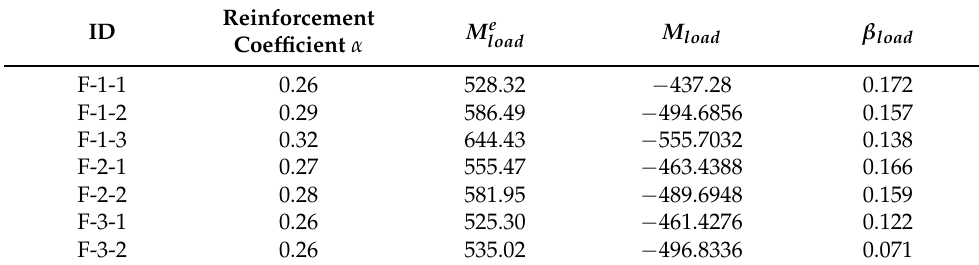
Table 5. External load moment amplitude modulation factor. ID